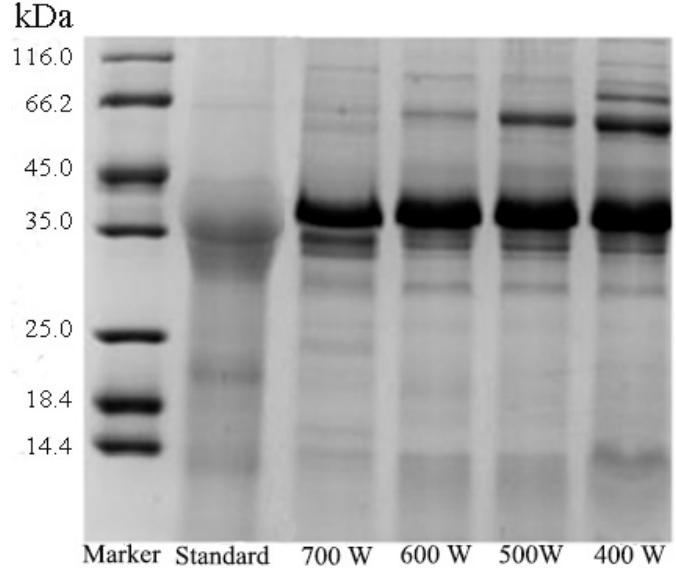
Figure 3. SDS-PAGE of Pv for different ultrasound powers (400, 500, 600, and 700 W). Other operating conditions: Heating temperature, 80 ◦ C; heating time, 15 min; and ultrasound time, 10 min. Table 2. E ff ect of ultrasound power (W) on purity, N / P and activity of Pv. Ultrasound Power (W)